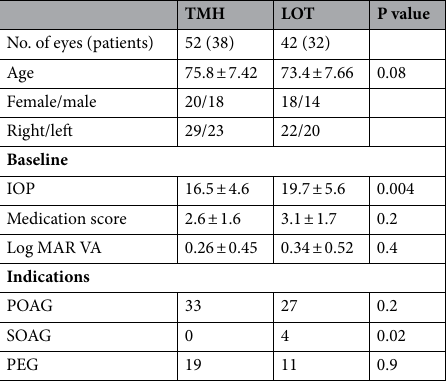
Table 1. Preoperative characteristics of patients who underwent trabeculotomy. Data are presented as mean ± standard division or number. IOP: intraocular pressure; Log MAR VA: logarithm minimal angle resolution visual acuity; POAG: primary open angle glaucoma; SOAG: secondary open angle glaucoma; PEG: pseudo exfoliation glaucoma.